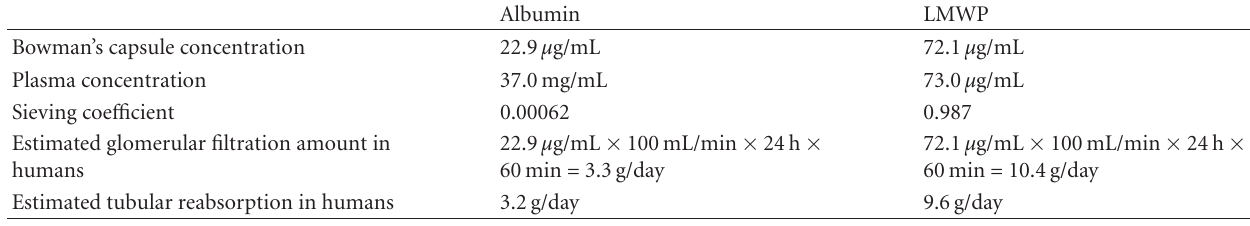
Table 2: Glomerular filtration and reabsorption of albumin and low-molecular weight proteins (LMWP) in humans estimated from rat micropuncture data [12].